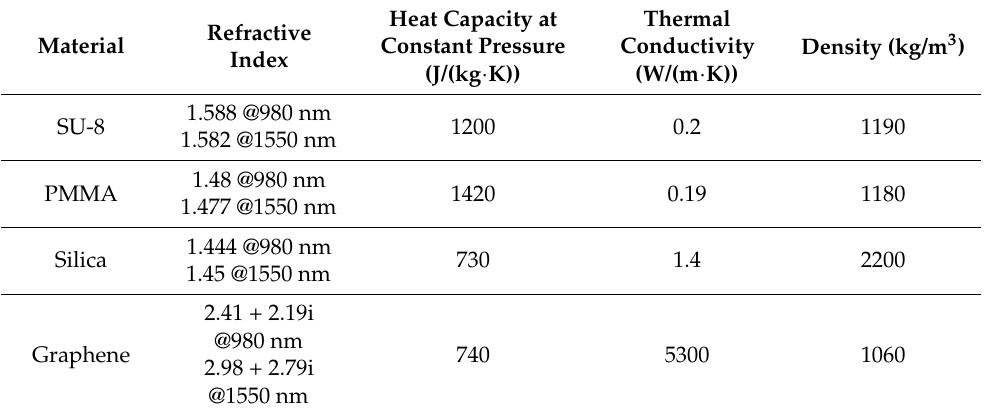
Table 1. Related material parameters in the